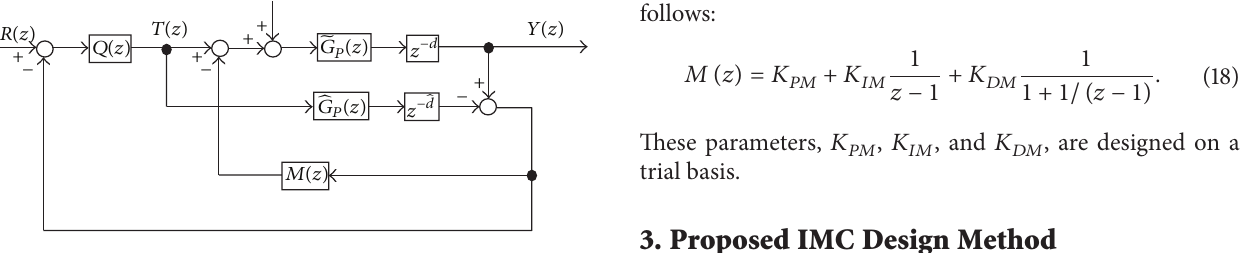
Figure 1: A block diagram of the proposed